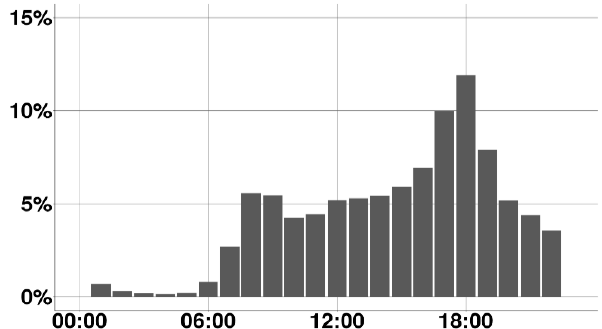
Figure 2. Distribution of charging sessions for fast chargers over the day.